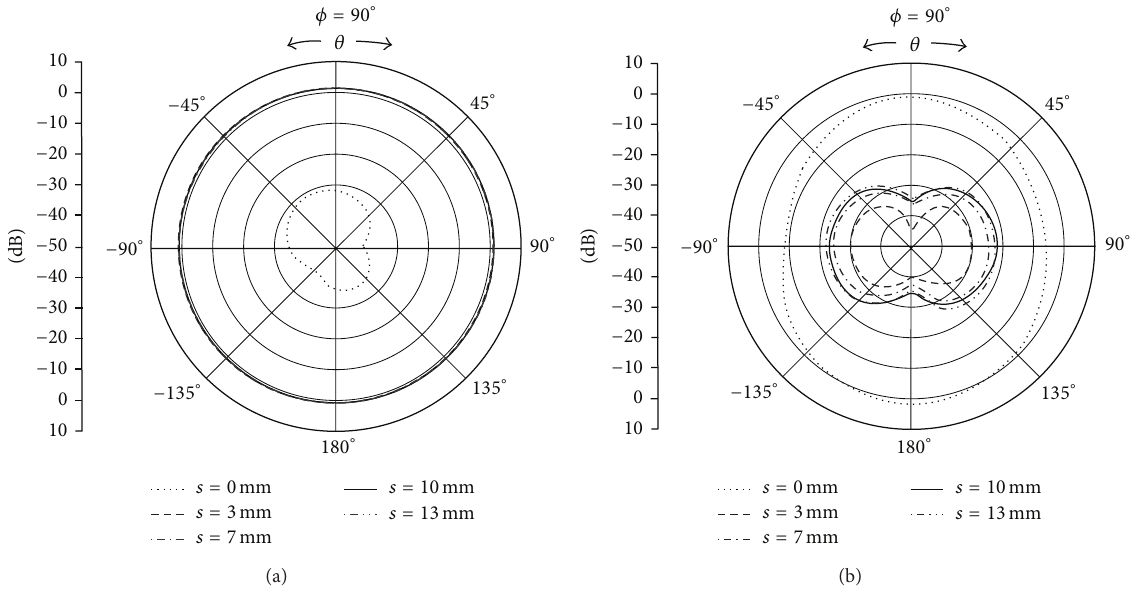
Figure 17: Simulated radiation patterns in the 𝑦 - 𝑧 plane at respective resonant frequencies as a function of 𝑠 (a) copolarization (𝐸 𝜙 ) and (b) cross-polarization (𝐸 𝜃 ) .